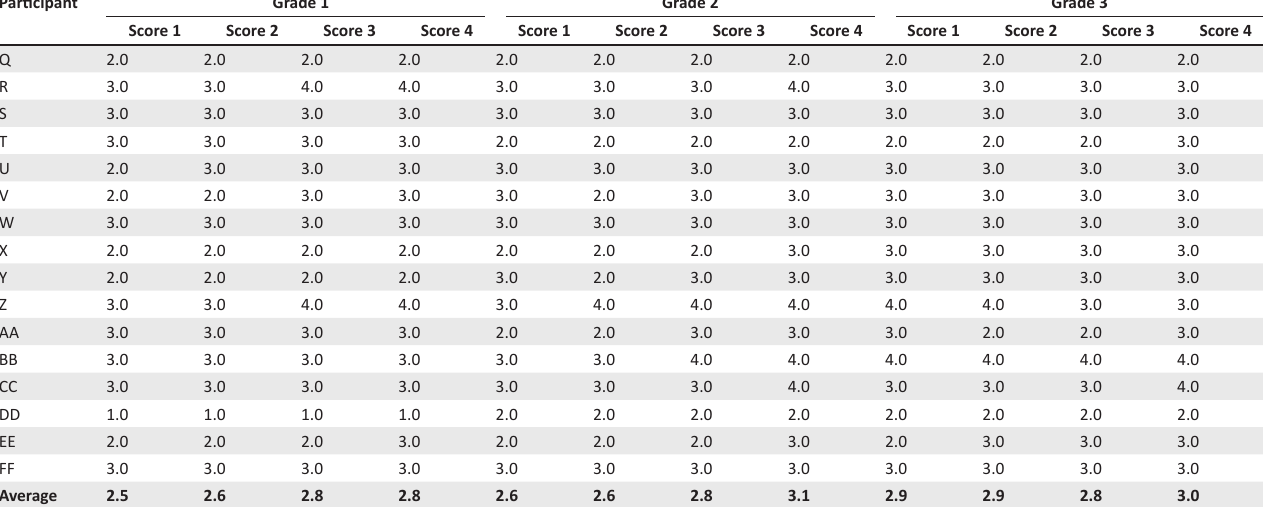
TABLE 4: Reading results of learners in the group that did not participate in the schools’ music instruction programme – The comparative group.